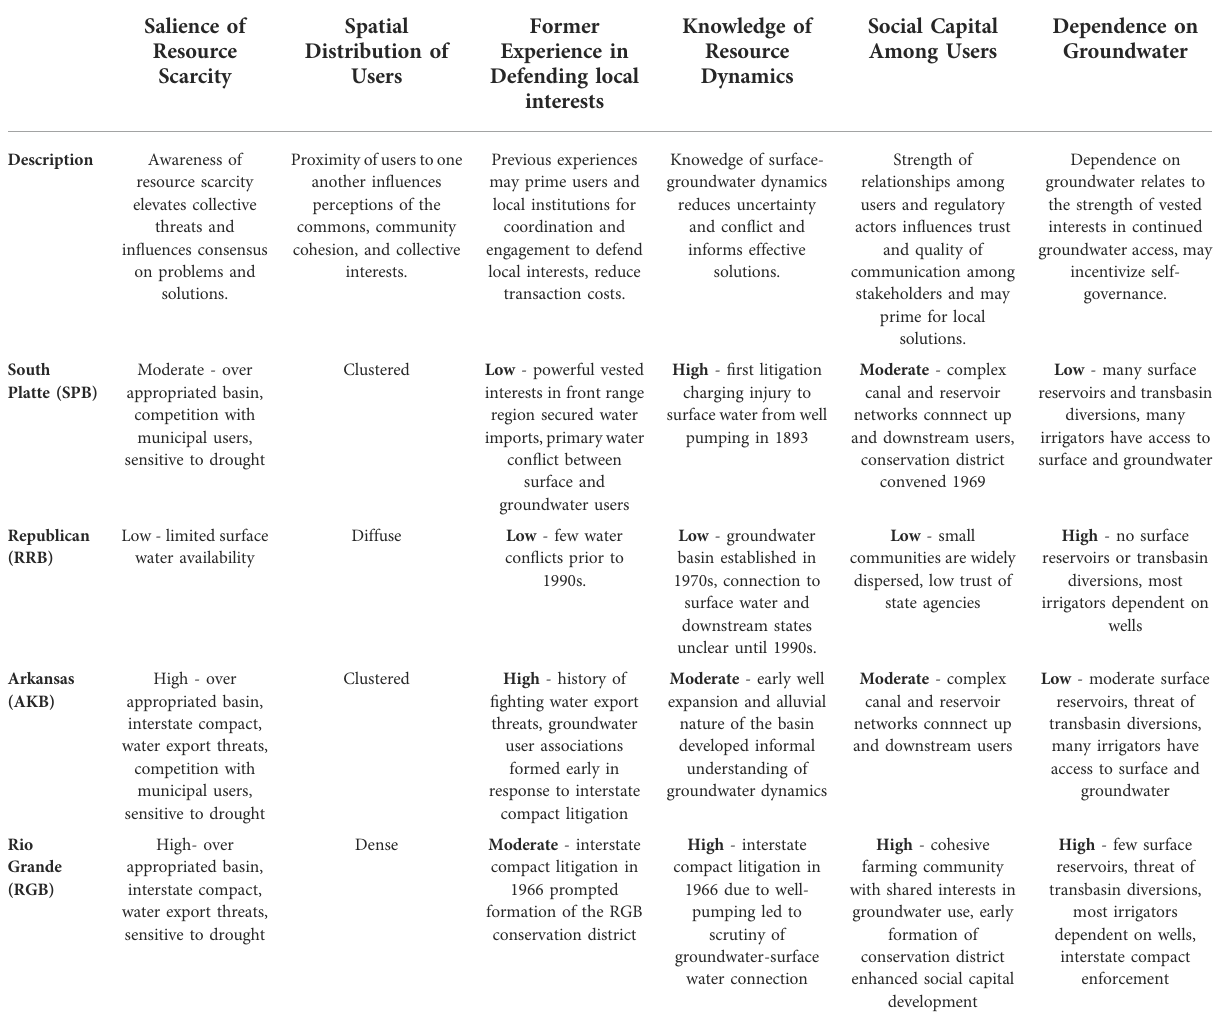
TABLE 1 We hypothesize that several attributes of groundwater user communities and resource systems are in fl uential in convincing irrigators to respondtodisturbancescollectivelyinsteadofindividually.Variables areevaluatedusing multipledatasources andinterviews, anddescribedfor each basin during the 1970s when Colorado began to efforts to regulate groundwater